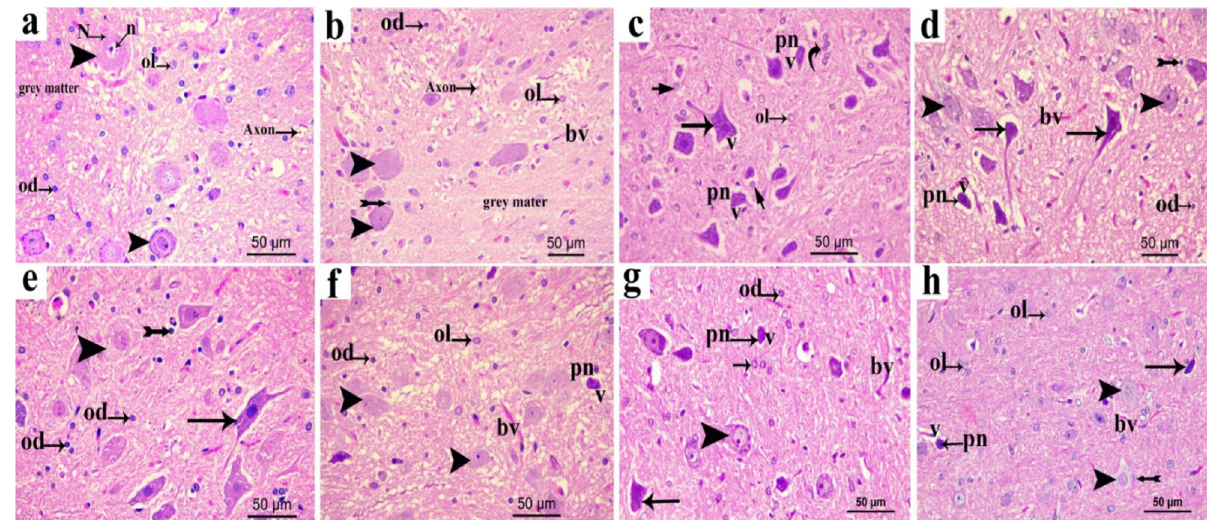
Figure 8. Representative photomicrographs in sections of brain stem from various groups ( a ) control group; ( b ) sham group; ( c ) CCI group; ( d ) pregabalin group; ( e ) TF (p.o., 200 mg/kg); ( f ) TF (p.o., 400 mg/kg). ( g ) TA (p.o., 200 mg/kg); ( h ) TA (p.o., 400 mg/kg). Arrowhead, arrow, short arrow bifid arrow illustrate normal neurons, affected neurons with dark stained cytoplasm and nuclei, perineural glial cell nuclei rarified lightly stained cytoplasm and nuclei, respectively.pn; pyknotic nuclei N; Nissl granule, n; nuclei bv, normal blood vessel; v; vacuolated cytoplasm, Ol: lightly stained glial cell, Od: deeply stained glial cell. Scale bar, 50 μm × 400.